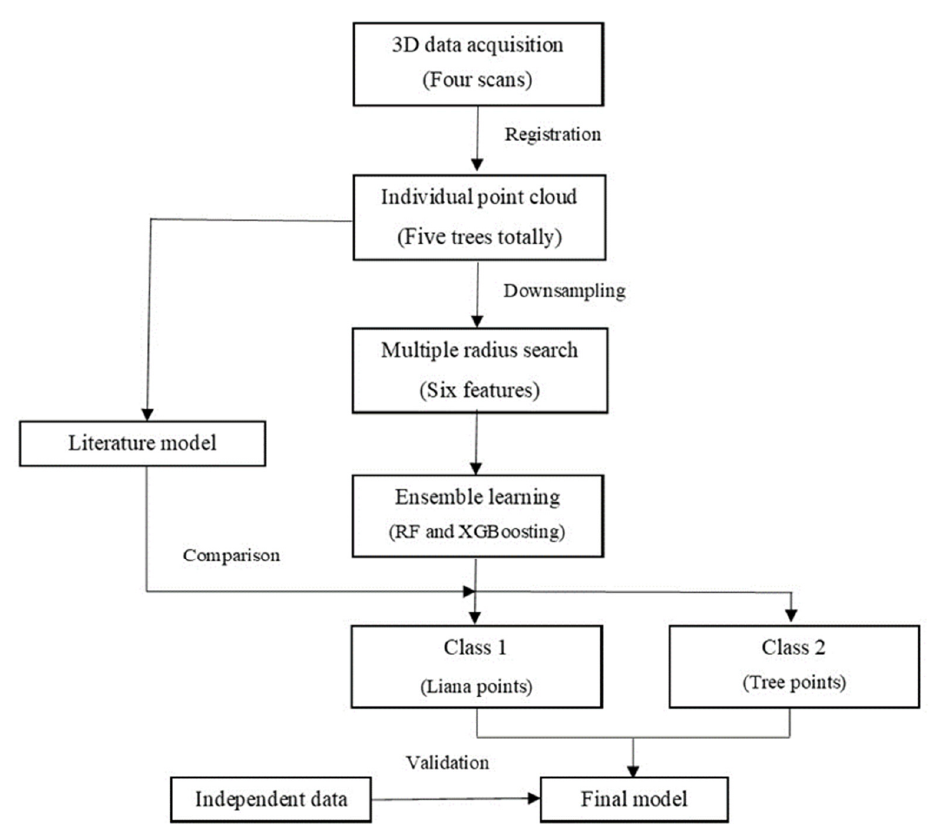
Figure 2. The main steps used in the presented geometric method based on RF and XGBoosting algorithms for liana/tree separation.